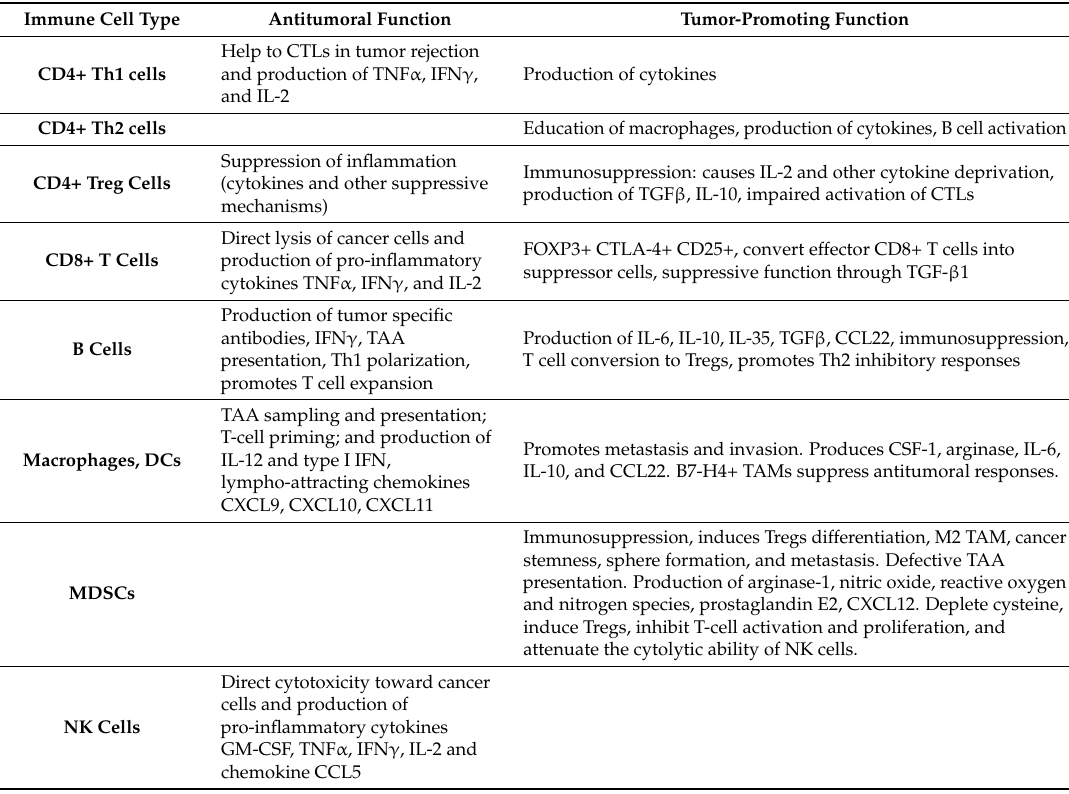
Table 1. Main subsets of immune infiltrating cells in epithelial ovarian cancer (EOC) tumor microenvironment